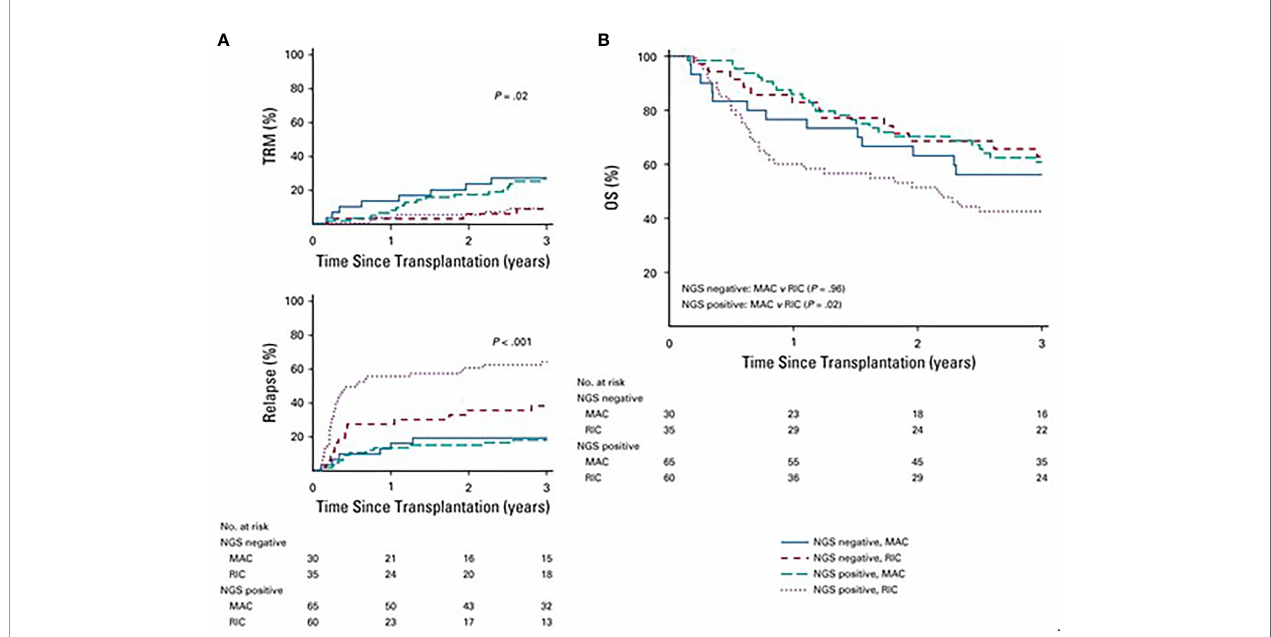
FIGURE 9 | (A) Differences in rates of transplant- relates mortality (TRM) based on conditioning intensity and mutational status (P= .02). TRM was signi fi cantly hihger in patient who underwent MAC v RIC but there was no difference on the basis mutational satatus (P=8). Patients with RIC had higher relapse rather than MAC ( P < .001) with highest risk of relapse in the next-deneration aequencing (NGS) positive patients who received RIC (P < .001). (B) In patients who were NGS negative, overall survival (OS) did not differ on the basis of conditioning intensity (3-year OS, 63% RIC v 56% MAC; P= .96). However, in those with detectable